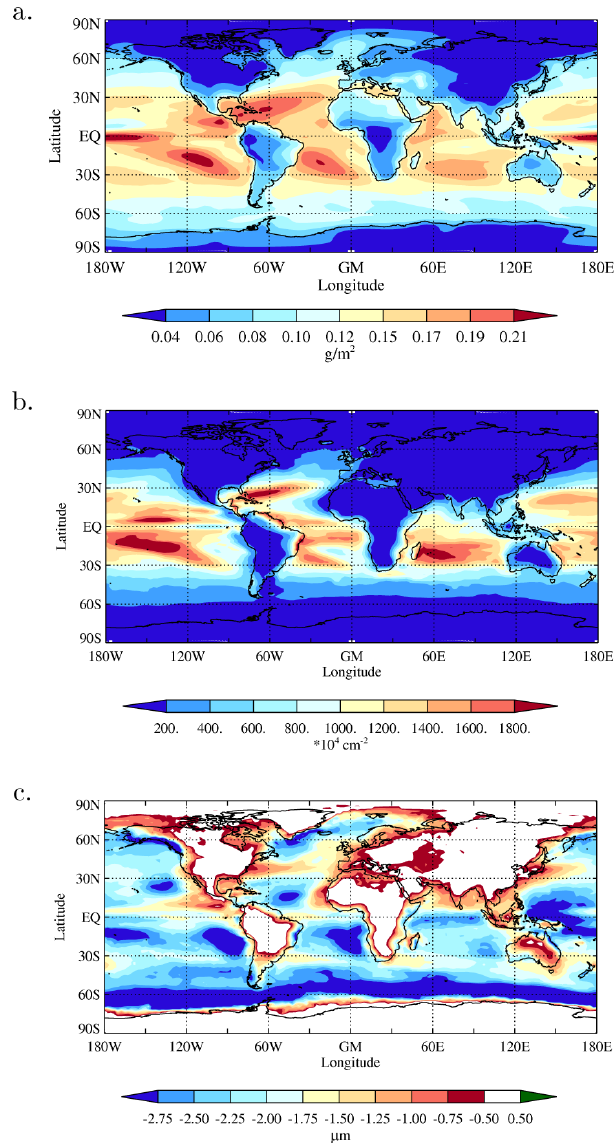
Fig. 7. Changes due to increased sea salt emissions (NorESM): (a) column integrated sea salt (gm − 2 ), (b) column integrated cloud droplet number concentration (cm − 2 ), and (c) effective cloud droplet radius (µm) at ∼ 930hPa. All annual